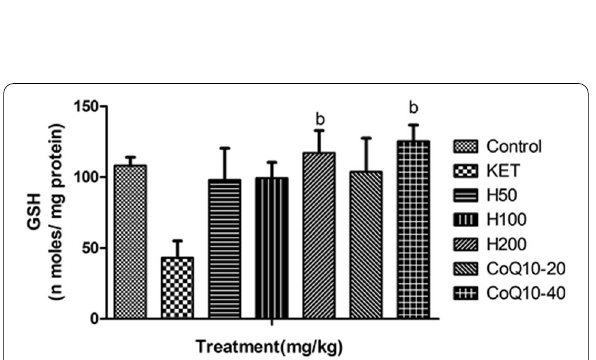
Fig. 5 Effect of Hesperidin and Coenzyme Q10 on GSH levels in the prefrontal cortex regions of the brain. Data were analyzed by one-way ANOVA followed by Tukey’s post hoc analysis. All values were expressed as Mean SEM. a p < 0.05 as compared to naive, b p < 0.05 ± as compared to ketamine. KET, Ketamine; H, Hesperidin; CoQ10,